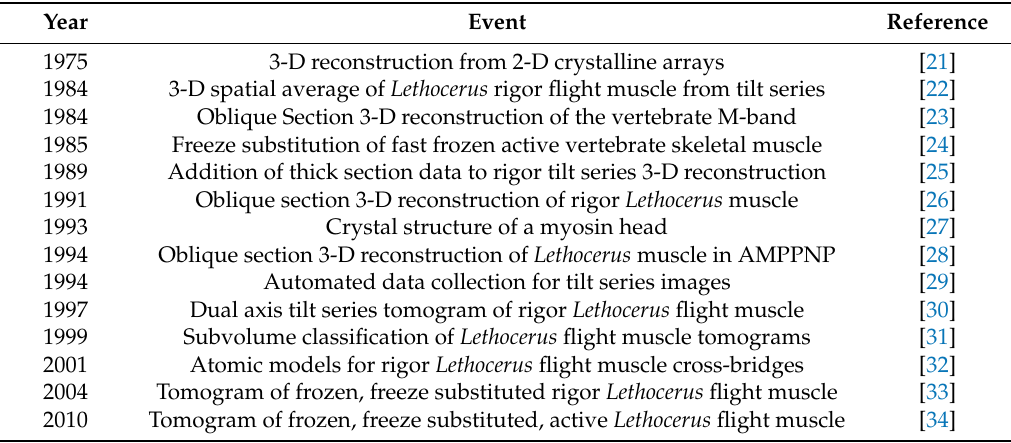
Table 1. Timeline of Lethocerus flight muscle 3D